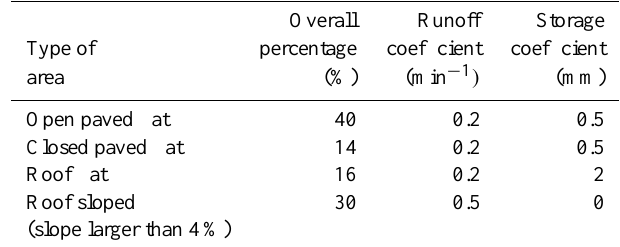
Table 1. Surface characteristics of the central district catchment in Rotterdam used for hydrodynamic modelling: percentage, runoff coefficient and storage coefficient.